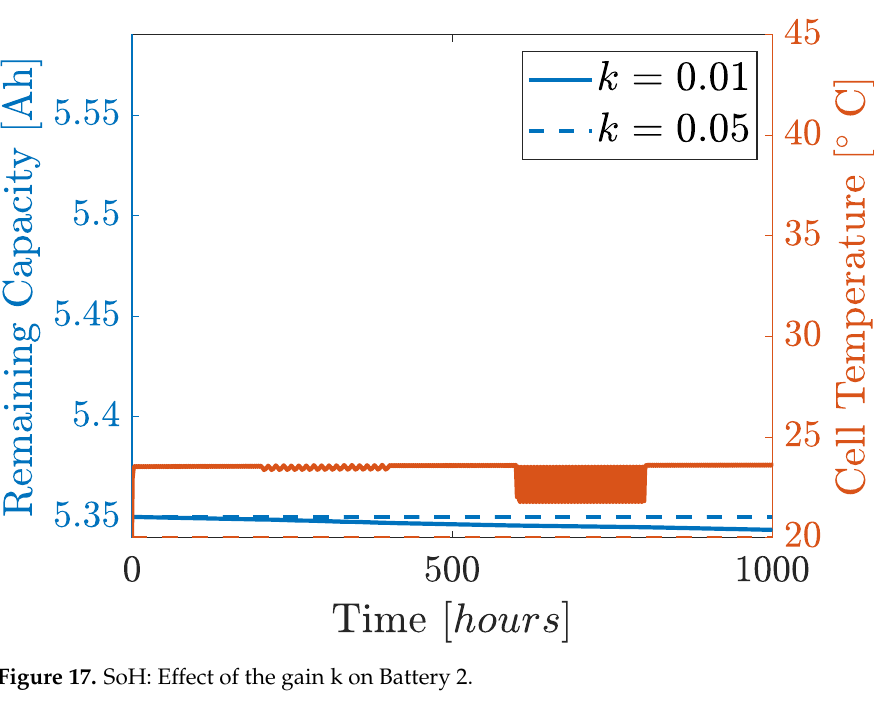
Figure 17. SoH: Effect of the gain k on Battery 2.